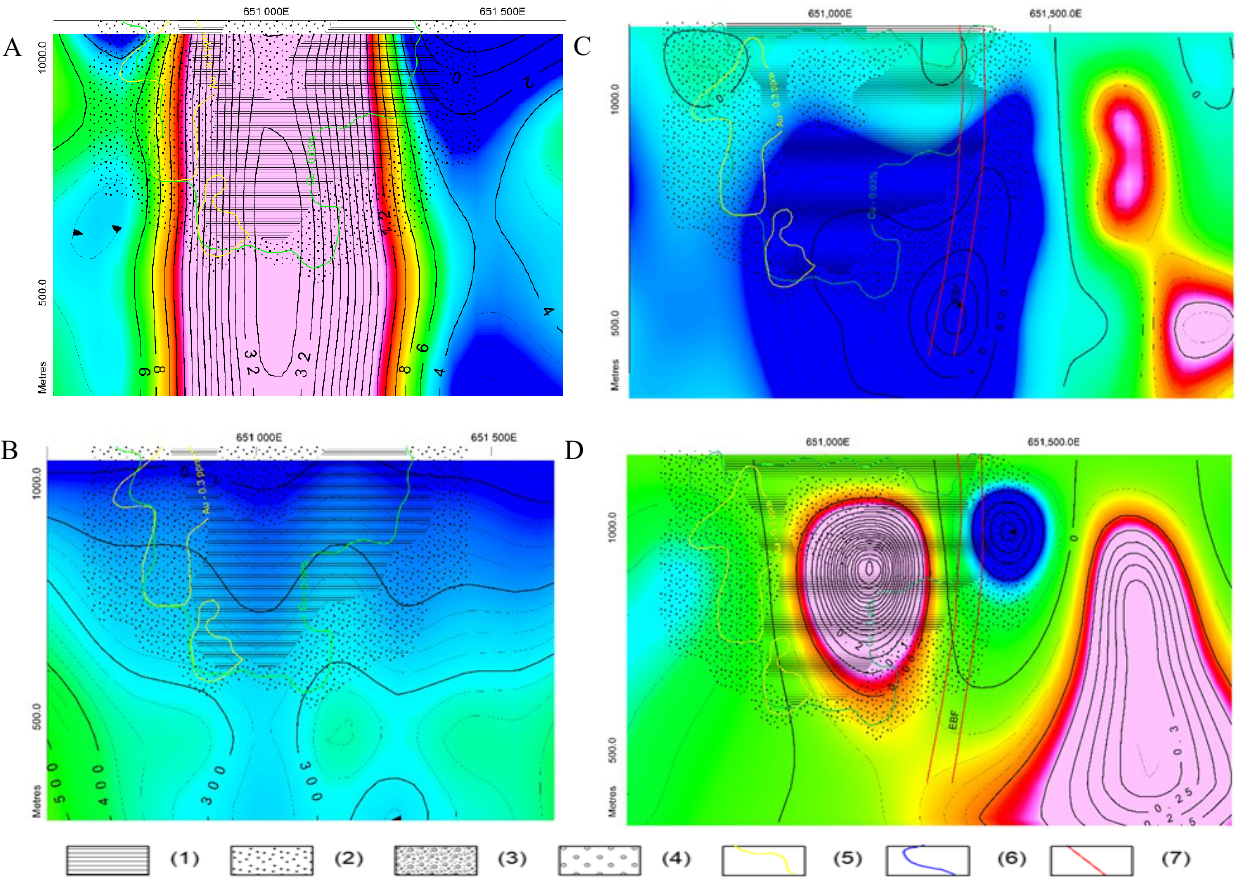
(1) Advanced Argillic alteration zone; (2) Phyllic alteration zone; (3) Prophyllitic alteration zone; (4) Potassic alteration zone; (5) Gold grade isoline – 0.3 ppm; (6) Copper grade isoline – 0.3%; (7) Faults Fig. 11. Sections of CO along B - B lines: The chargeability (top left), the resistivity (bottom left), the magnetic susceptibility (top right), and the density (bottom